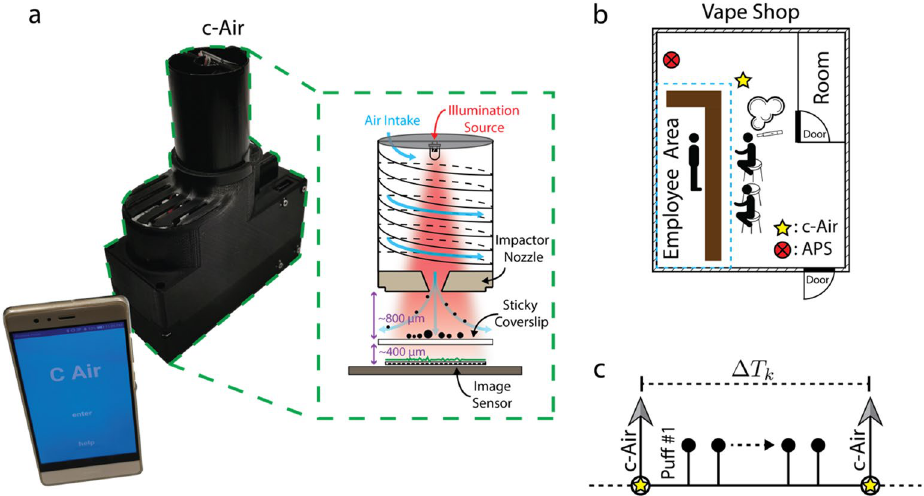
Figure 1. The c-Air device and the field experiments in a vape shop for aerosol volatility measurements. ( a ) A photograph of the c-Air device and the mobile phone application to interface with the device. The schematic of the c-Air device. ( b ) Floor plan of the vape shop, marking the measurement devices and e-cig users. ( c ) A schematic timing diagram of vaping events and c-Air